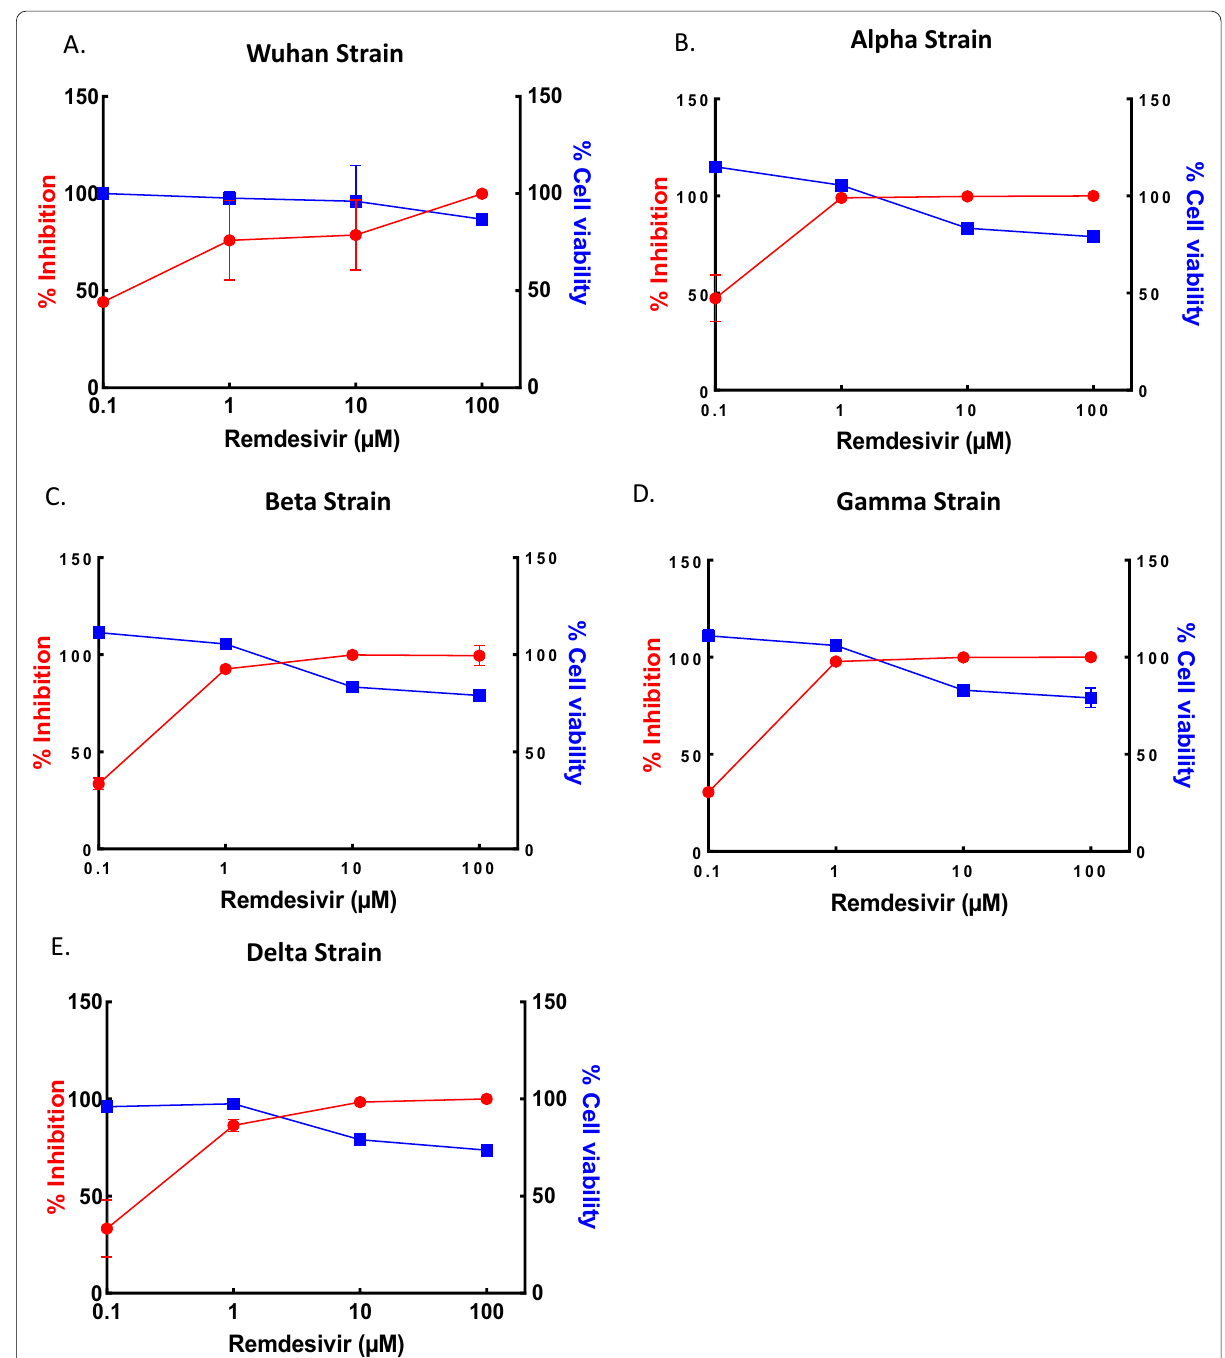
Fig. 1 Corroboration of the antiviral effect of remdesivir against SARS-CoV-2 variants. Vero E6 cells were pretreated with remdesivir for 72 h and challenged with SARS-CoV-2. Infected cell supernatants at 48 h pi (MOI 0.02) were quantified by quantitative real time RT-PCR assay. The blue and red lines represent the CC 50 and IC 50 , respectively; the blue squares represent cell viability (%) and the red circles represent SARS-CoV-2 infection inhibition (%). All experiments were performed in